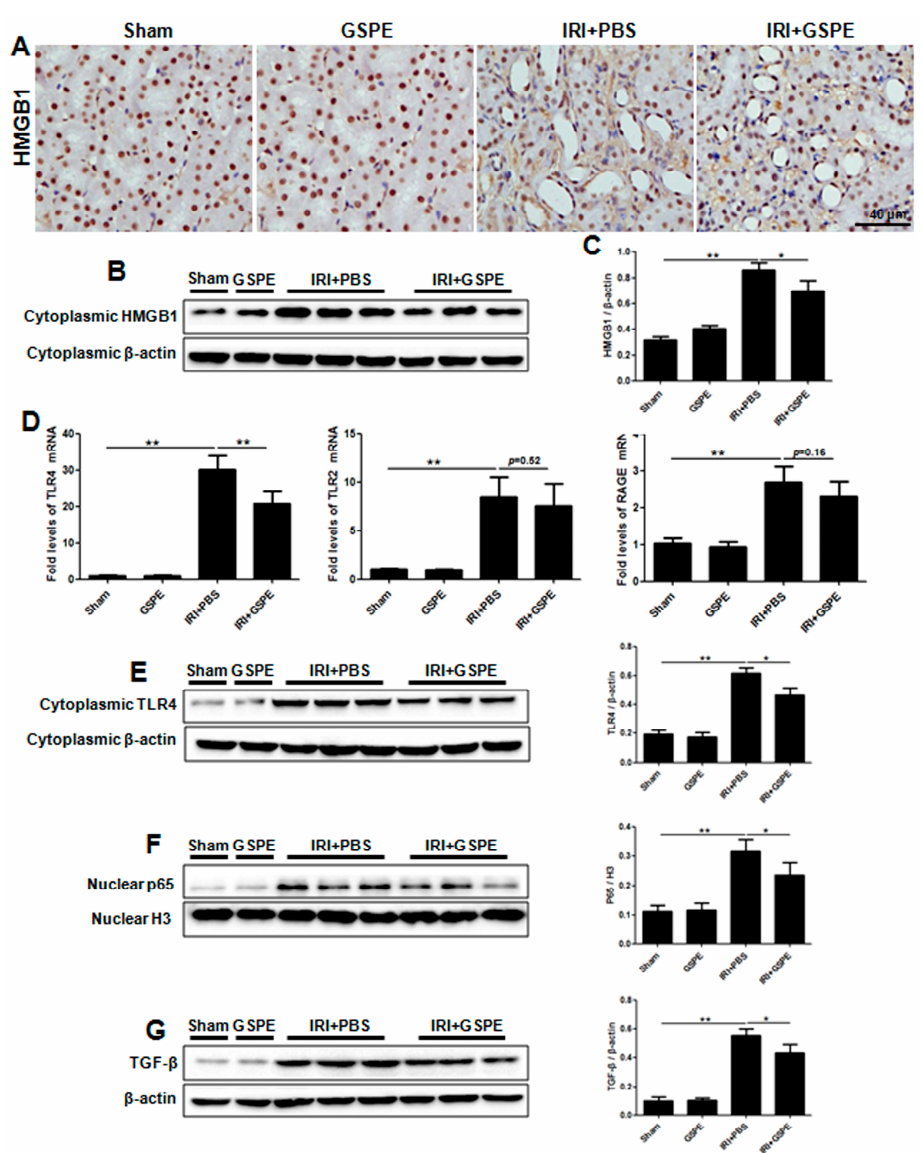
Figure 7. Successive treatment with GSPE suppresses the activation of HMGB-TLR4-p65-TGF- β . ( A ) Immunohistochemical staining showed HMGB1 released into the cytoplasm and the renal interstitium after the I/R operation; ( B ) Cytoplasmic HMGB1 was assessed by Western blot; ( C ) The gray intensity analyses for HMGB1 are shown in bar graphs; ( D ) Real-time PCR was employed to detect the mRNA level of TLR4, TLR2 and RAGE in the kidney; ( E ) The protein level of TLR4 in the renal cytoplasm was detected by Western blot; ( F ) Western blot analysis for P65 was performed using a nuclear protein sample; ( G ) Western blot analysis for TGF- β was performed using total protein samples from kidneys. The data shown are mean ± SEM (* p < 0.05, ** p < 0.01; n = 7 per group).